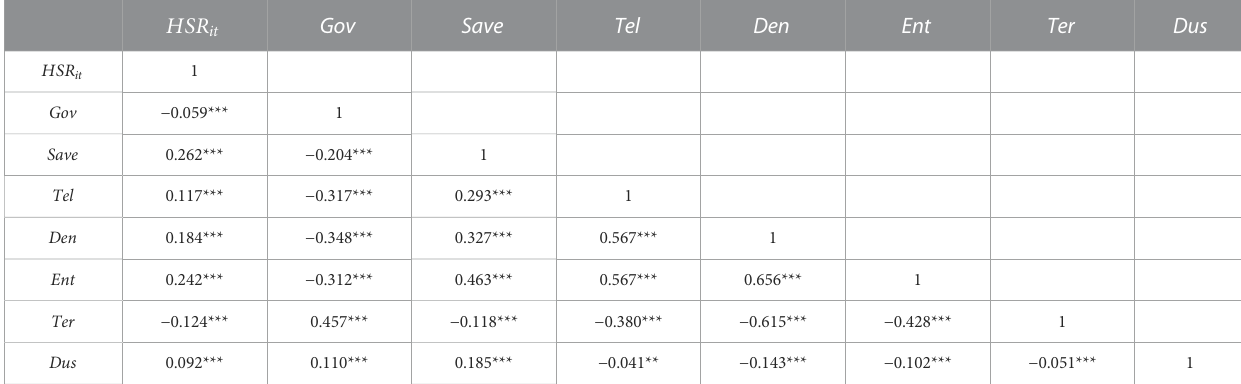
TABLE 4 Pearson correlation coef fi cient.